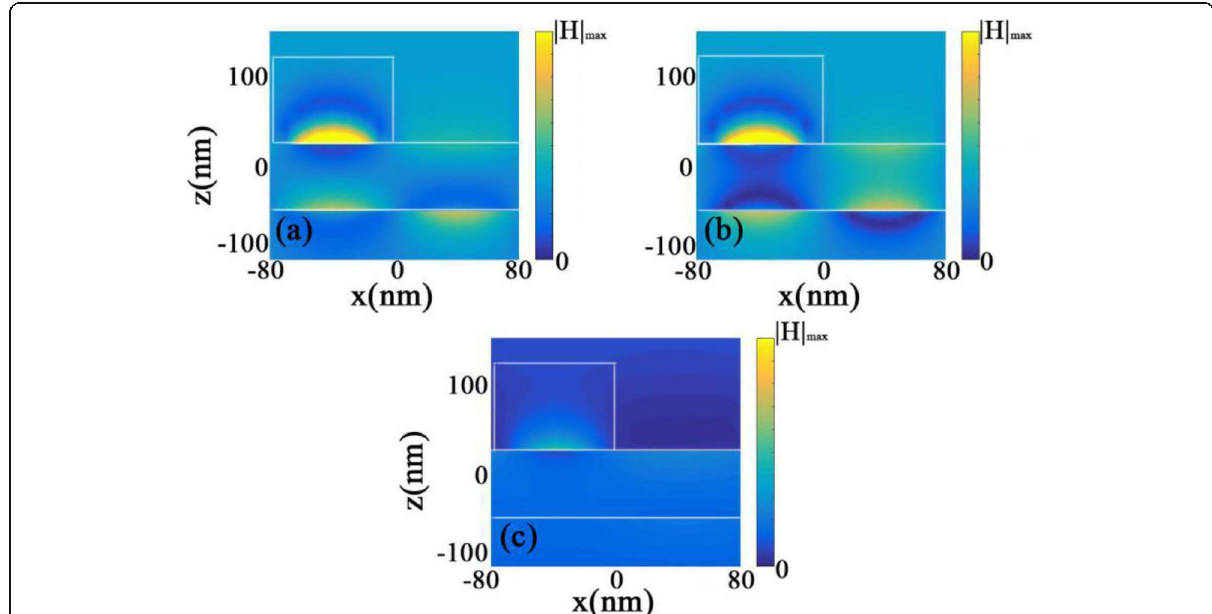
Fig. 4 Contour profiles of normalized magnetic fields of the proposed graphene-based CPA ( a ) at λ 1 = 9611 nm, ( b ) λ 2 = 9924 nm, and